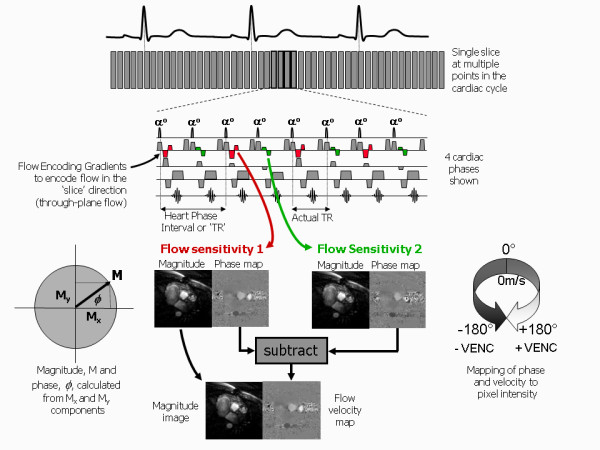
A retrospectively-gated, cine spoiled gradient echo pulse sequence (top) is shown in detail for four cardiac phases. In this example the standard imaging gradients are modified in the slice-selection direction to encode flow velocity components perpendicular to the image plane. For each cardiac phase the gradient echo pulse sequence is acquired twice, with two different flow sensitivities, indicated here by the red and green gradient pulses. The heart phase interval or ‘effective TR’ of the velocity encoded sequence is double the actual TR of the gradient echo pulse sequence. The Mx and My components of the MR signal are used to calculate both the signal magnitude, M, and the signal phase, ϕ, for each pixel. The phase maps for the two different flow sensitivities are subtracted to remove background phase shifts, creating a velocity map, which contains only velocity-related phase shifts due to the difference in flow velocity sensitivity between the two acquisitions. The flow sensitivities are chosen such that a subtracted phase difference of 180° corresponds to a predefined maximum velocity or VENC. The sign of the subtracted phase indicates the direction of flow along the encoded direction. The value of relative phase shift is mapped onto the pixel intensity scale such that a zero subtracted phase (stationary tissue) maps on to the centre of the pixel intensity scale (mid-grey). Positive and negative subtracted phases (corresponding to opposite directions of flow) are mapped onto higher and lower pixel intensities, respectively.